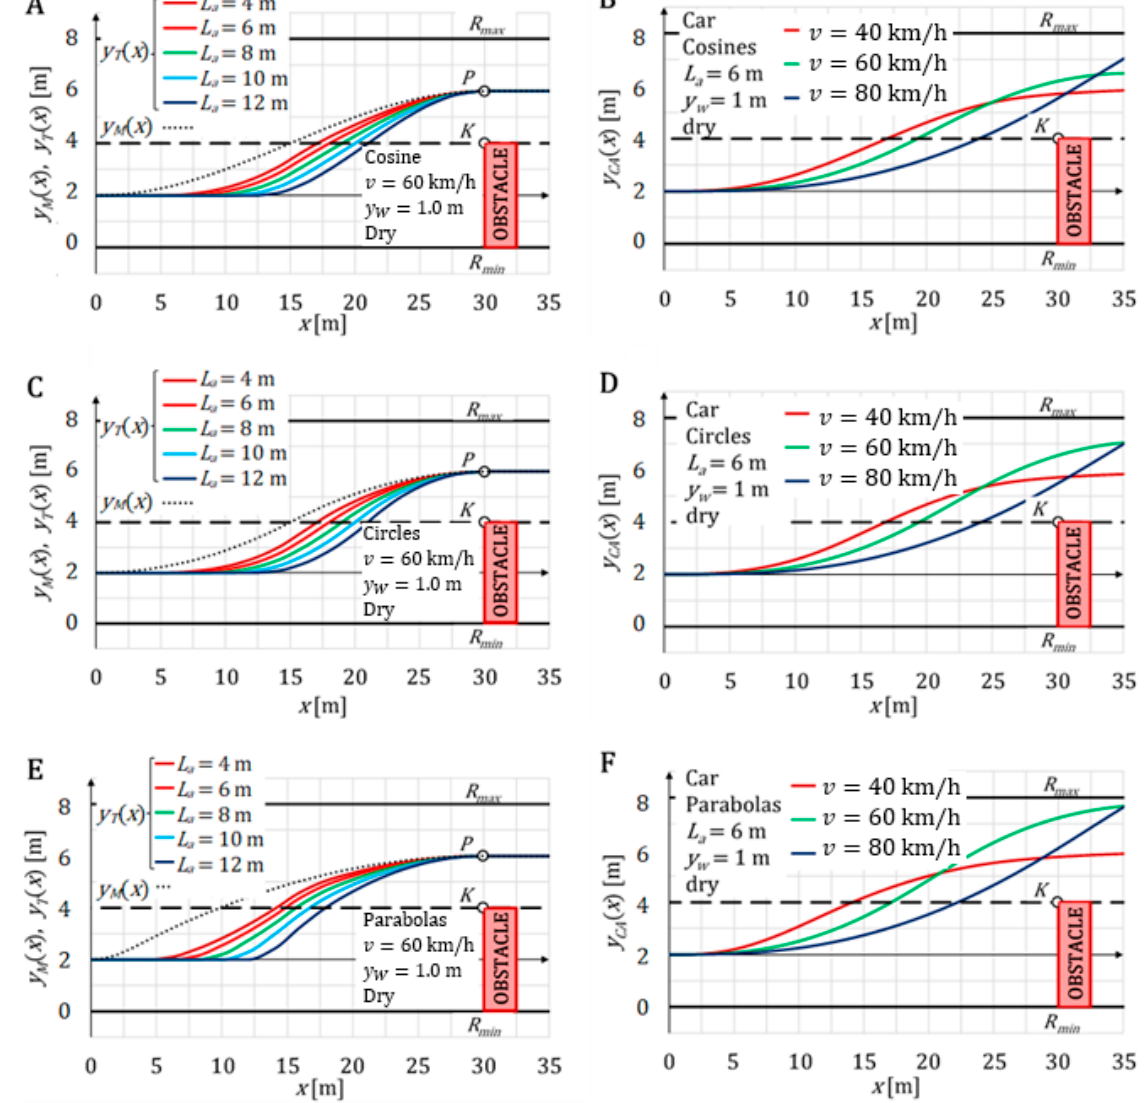
Figure 13. Comparison of trajectories y M ( x ) and y T ( x ) for different trajectory calculation methods (left) and of car paths y CA ( x ) obtained (right) for dry road surface; ( A , B )—method with a cosine curve; ( C , D )—method with circular arcs; ( E , F )—method with parabolas.